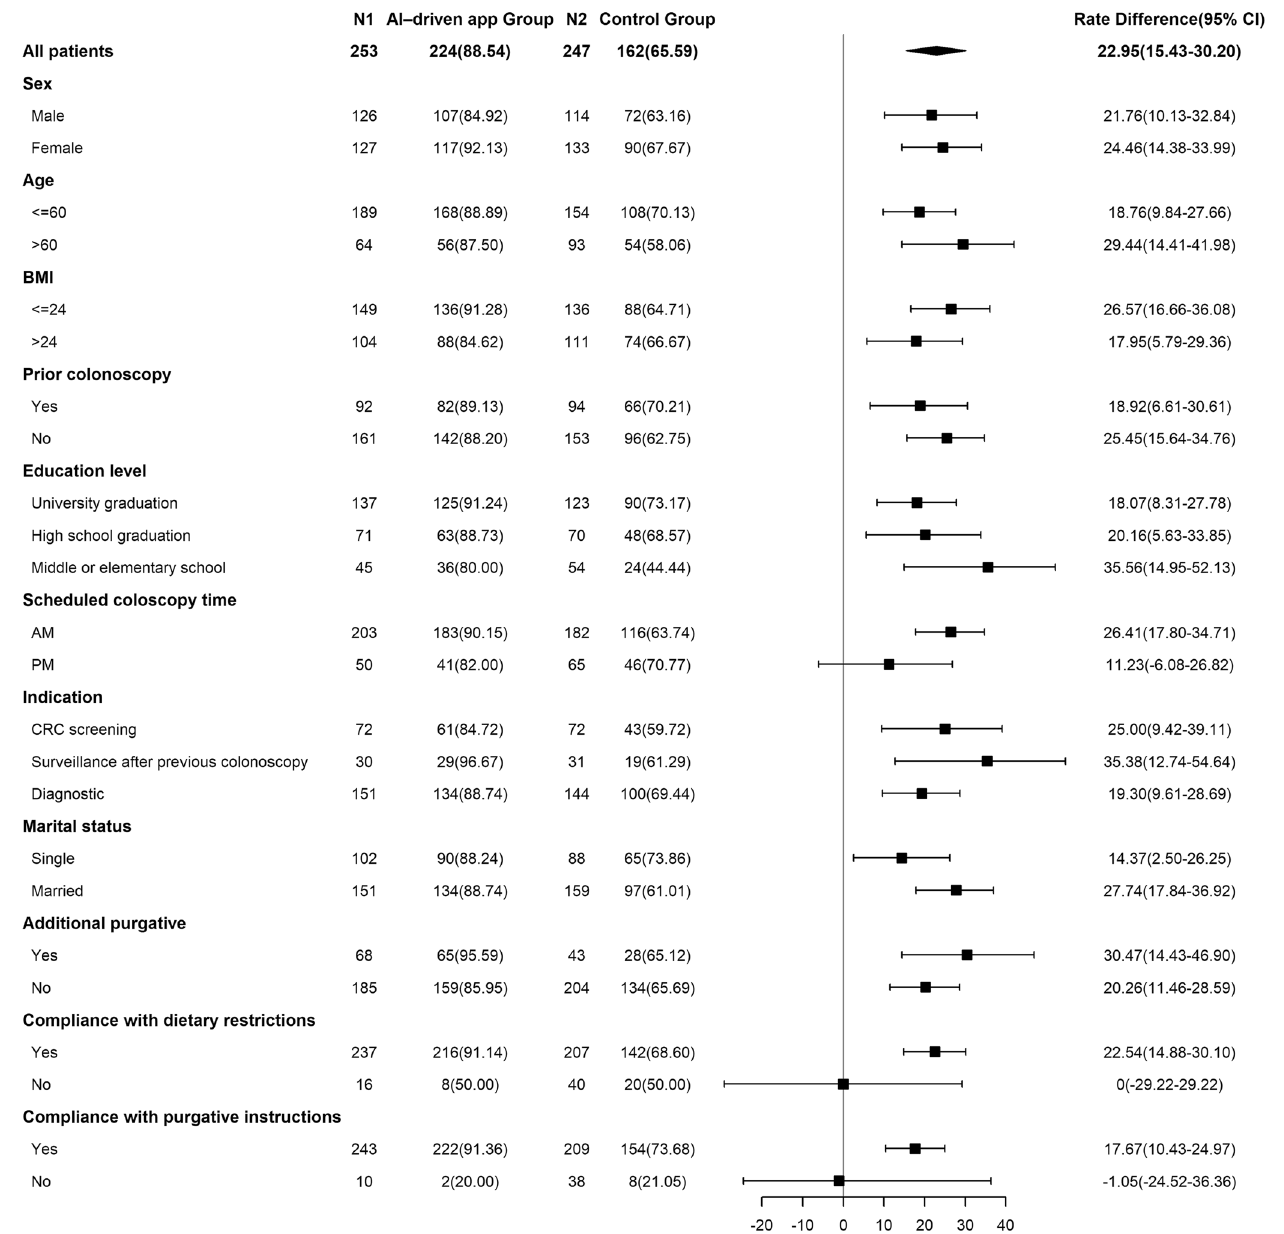
Fig. 2 Subgroup analysis of factors associated with the rate of adequate bowel preparation. BMI body mass index, CRC colorectal